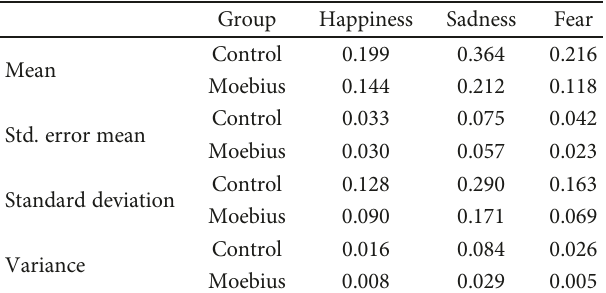
Figure 3: (a) Thermal modulation in an example control participant and Moebius patient during the “ happiness, ” “ sadness, ” and “ fear ” conditions. In the fi gure, the inlays present the entire nasal area, but elliptic nasal tip ROIs were used for analyses ( A = 297 pixels; MajorAxisLength = 20 35 pixels; MinorAxisLength = 18 64 pixels) [62, 65]. The control participant shows stronger thermal variation during the sadness condition than the Moebius patient. (b) Mean temperature values during each of the experimental conditions, baseline-corrected with respect to the neutral condition. Both control and Moebius participants show a signi fi cant nasal tip temperature increase during the “ sadness ” condition ( ∗ p ≤ 0 001 ). Means and standard errors (SE) are reported for each condition in both control and Moebius groups. Table 2: Descriptive statistics for each group and